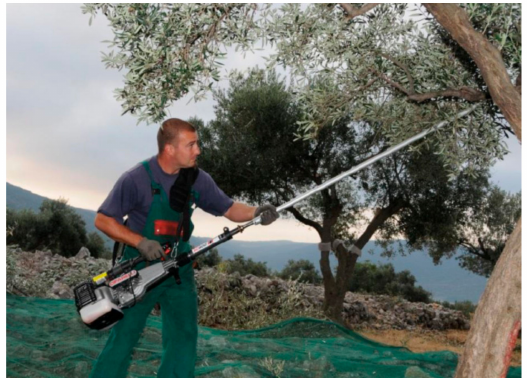
Figure 12. The branch shakers are the only mechanical addition—further mechanisation is not implemented since all of the olive trees are located on the dry stone wall enclosures and terraces [39].